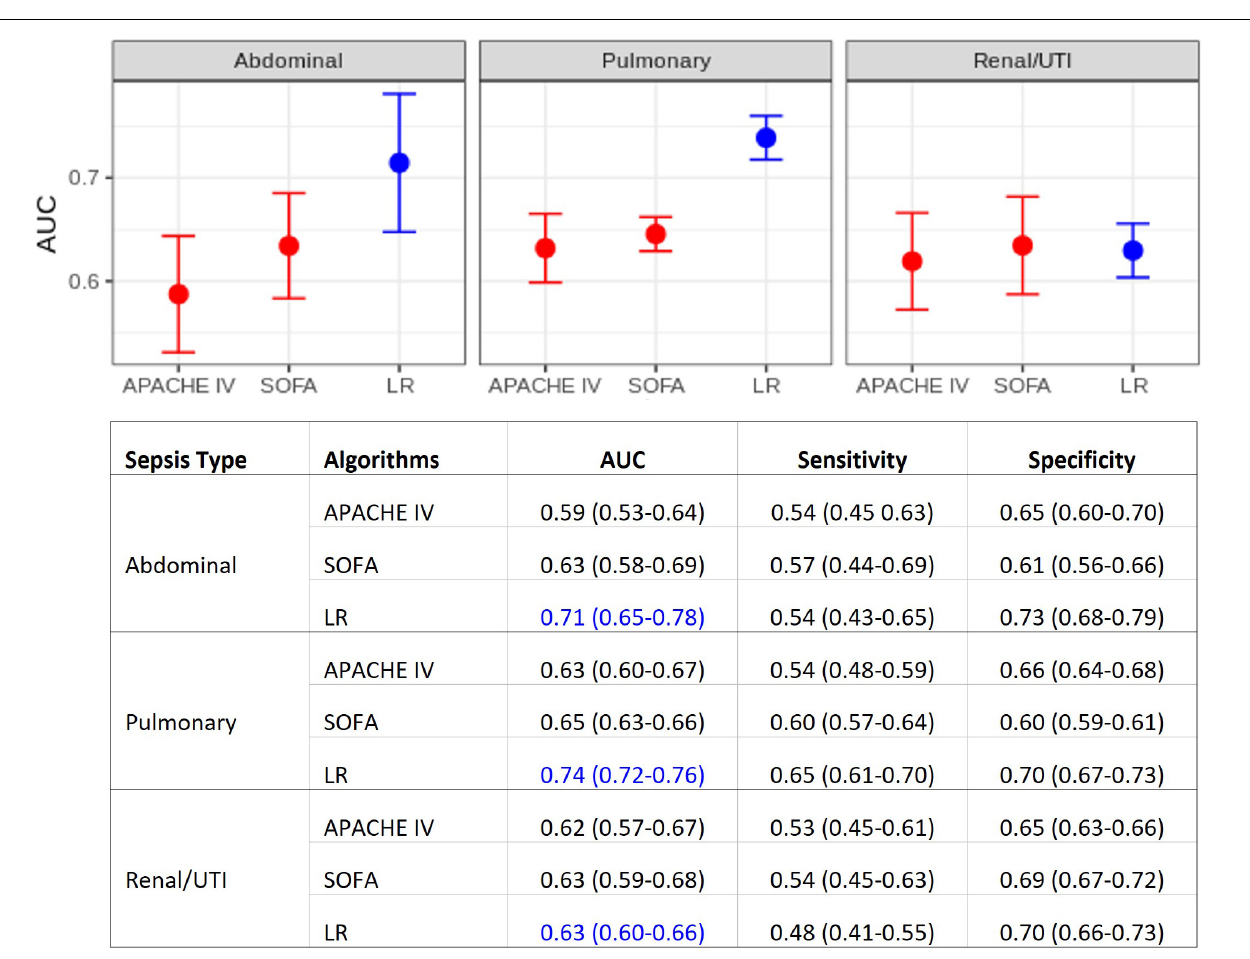
FIGURE 2 | Model performance comparisons. (Top) Area under the ROC curve (AUC) for each sepsis group. Average AUC (filled circles) and confidence intervals (vertical bars) estimated after the 10 repetitions of the outer cross-validation. Deterioration scores (APACHE IV and SOFA) models are represented in red, LR models in blue. (Bottom) Detailed comparison, also including sensitivity and specificity. APACHE IV, Acute Physiology And Chronic Health Evaluation IV; SOFA, Sequential Organ Failure Assessment; LR, multiple logistic regression.